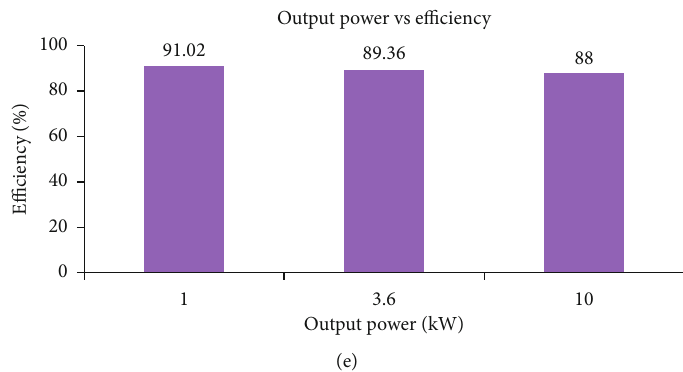
Figure 5: (a) Distinctive voltage waveform of 1 Ф seven-level BMLDCLC. (b) Characteristic output voltage waveform of 3 Ф BMLDCLC. (c) Analysis of conduction loss of BMLDCLC. (e) Losses and e ffi